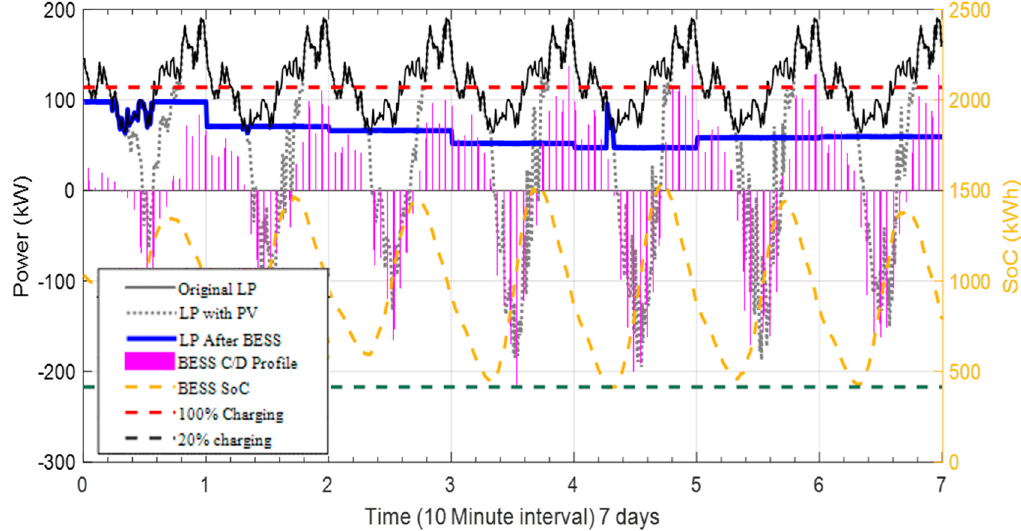
Table 3. Comparison of the duration of study for BESS design.